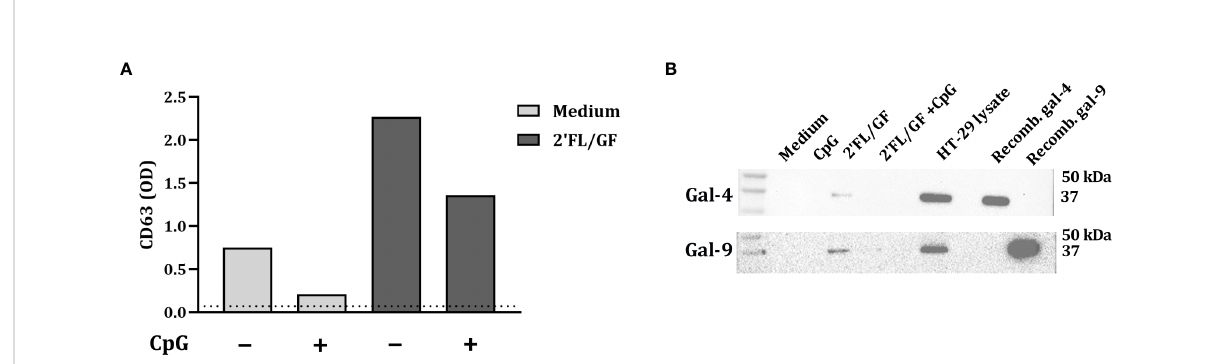
FIGURE 4 Galectin-4 and -9 are present in CD63-expressing exosomes. IEC (HT-29 cell line) were apically exposed to 0.5% ( w/v ) 2 ’ FL/GF alone or in combination with 0.5 µM CpG and basolaterally to a CD3/CD28-activated PBMC. After 24 h incubation, IEC were separated from PBMC, washed and incubated in fresh medium for additional 24 h (total 48h; 24h IEC/PBMC co-culture and additional 24h IEC culture) after which the basolateral supernatant was collected and exosomes isolation was performed. The presence of exosomes was con fi rmed by measuring CD63 marker (A) by means of ELISA. The dotted line represent CD63 present in culture medium (non-exposed to IEC). Additionally, the presence of galectin-4 and -9 within CD63-expressing exosomes was studied by western blot (B) of n =